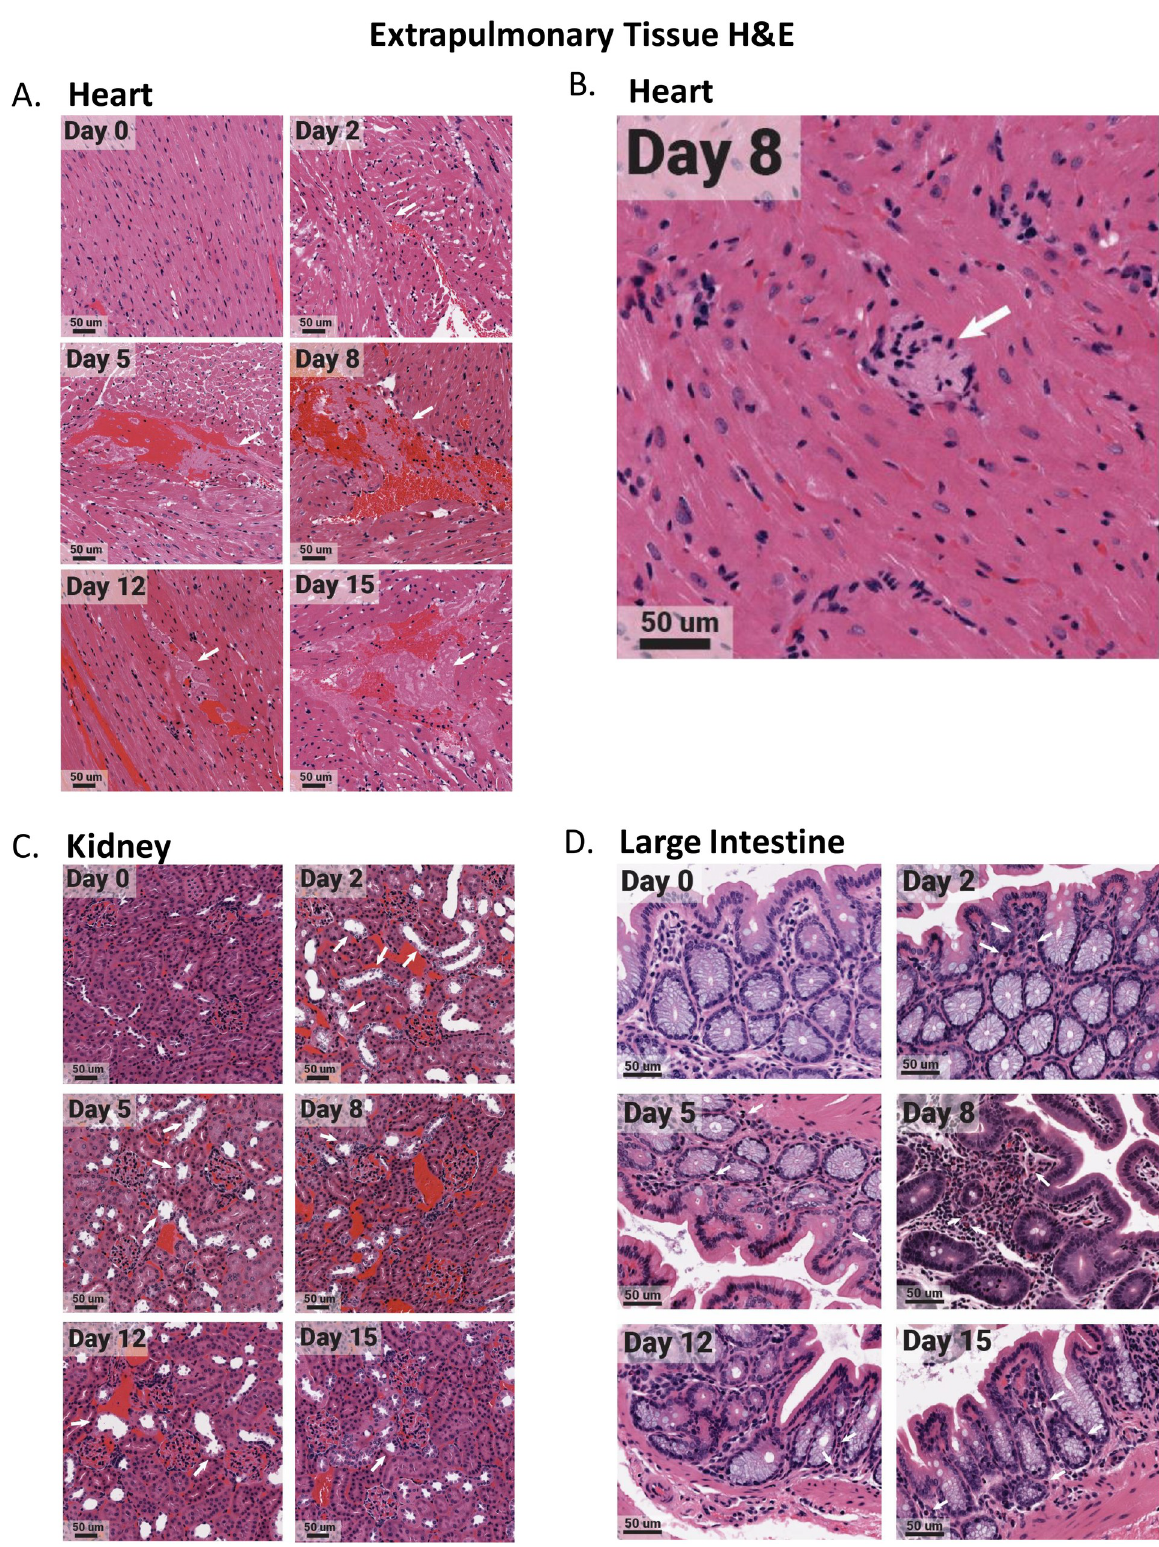
Fig 7. Select extrapulmonary organs have distinct pathology after SARS-CoV-2 infection with evidence of microthrombi and myocarditis in the heart, tubular damaging in the kidney, and eosinophil infiltration in the large intestine. The heart, kidney, and large intestine